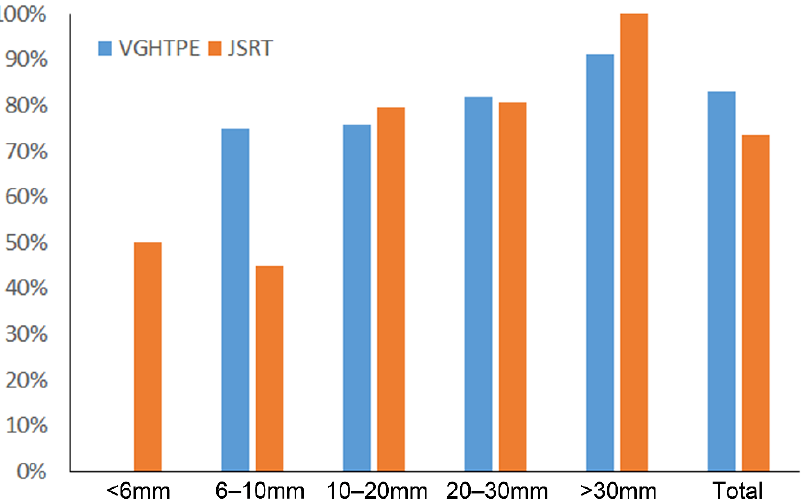
Figure 10. Sensitivity of the AI model (ensemble model) to detect a single lung nodule according to nodule size in the VGHTPE testing dataset and the JSRT dataset.